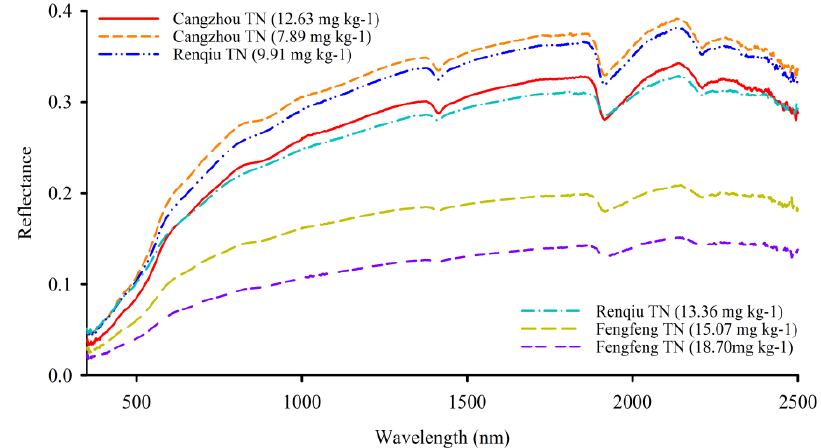
Figure 3. Original reflectance curve of soil samples with different TN contents.